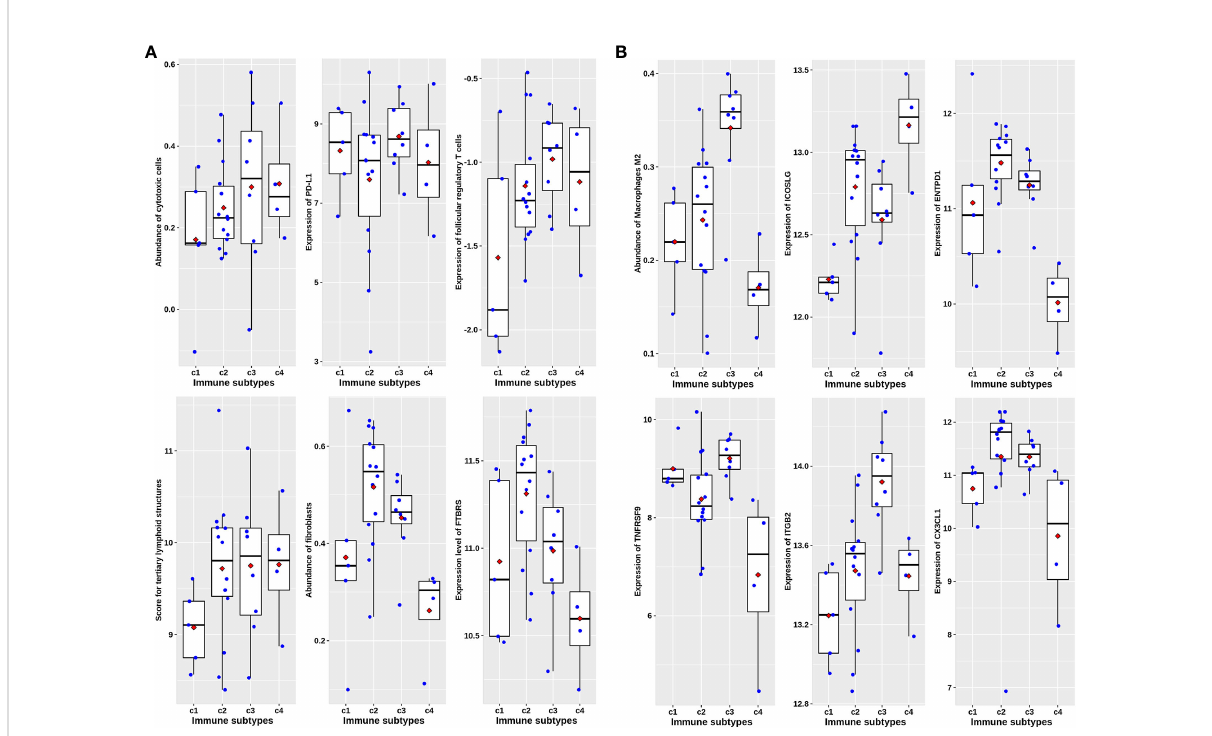
FIGURE 5 Immune characteristics among four immune subtypes in post-nCRT samples in GSE94104. (A) Scatter plots overlapped with box plots illustrating differences in six major immune related scores among four immune subtypes without statistical signi fi cance. (B) Scatter plots overlapped with box plots illustrating signi fi cant differences in six immune related scores among four immune subtypes. The red diamonds in each box indicate mean